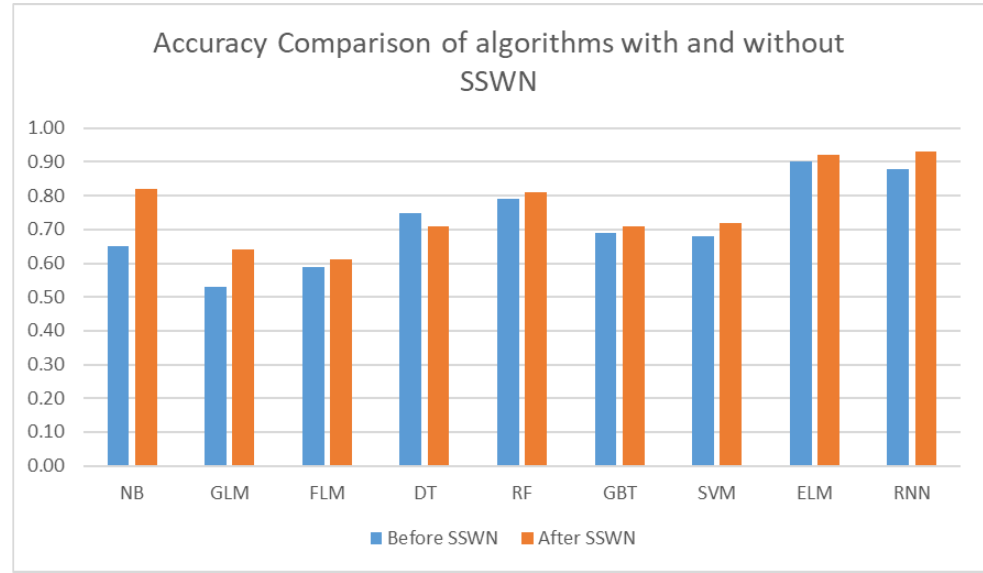
Figure 5. Accuracy comparison of algorithms before and after SSWN.